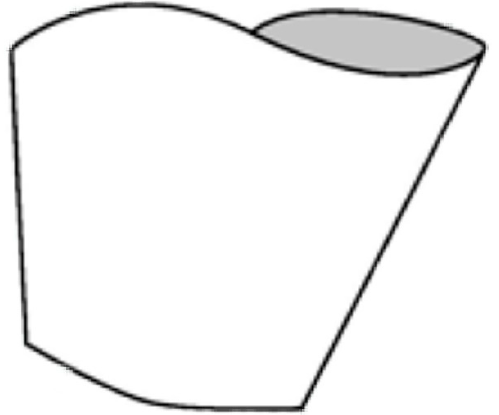
Figure 2. The structure of the β‐ cyclodextrin. The central cavity of the molecule can include guest molecules [28].